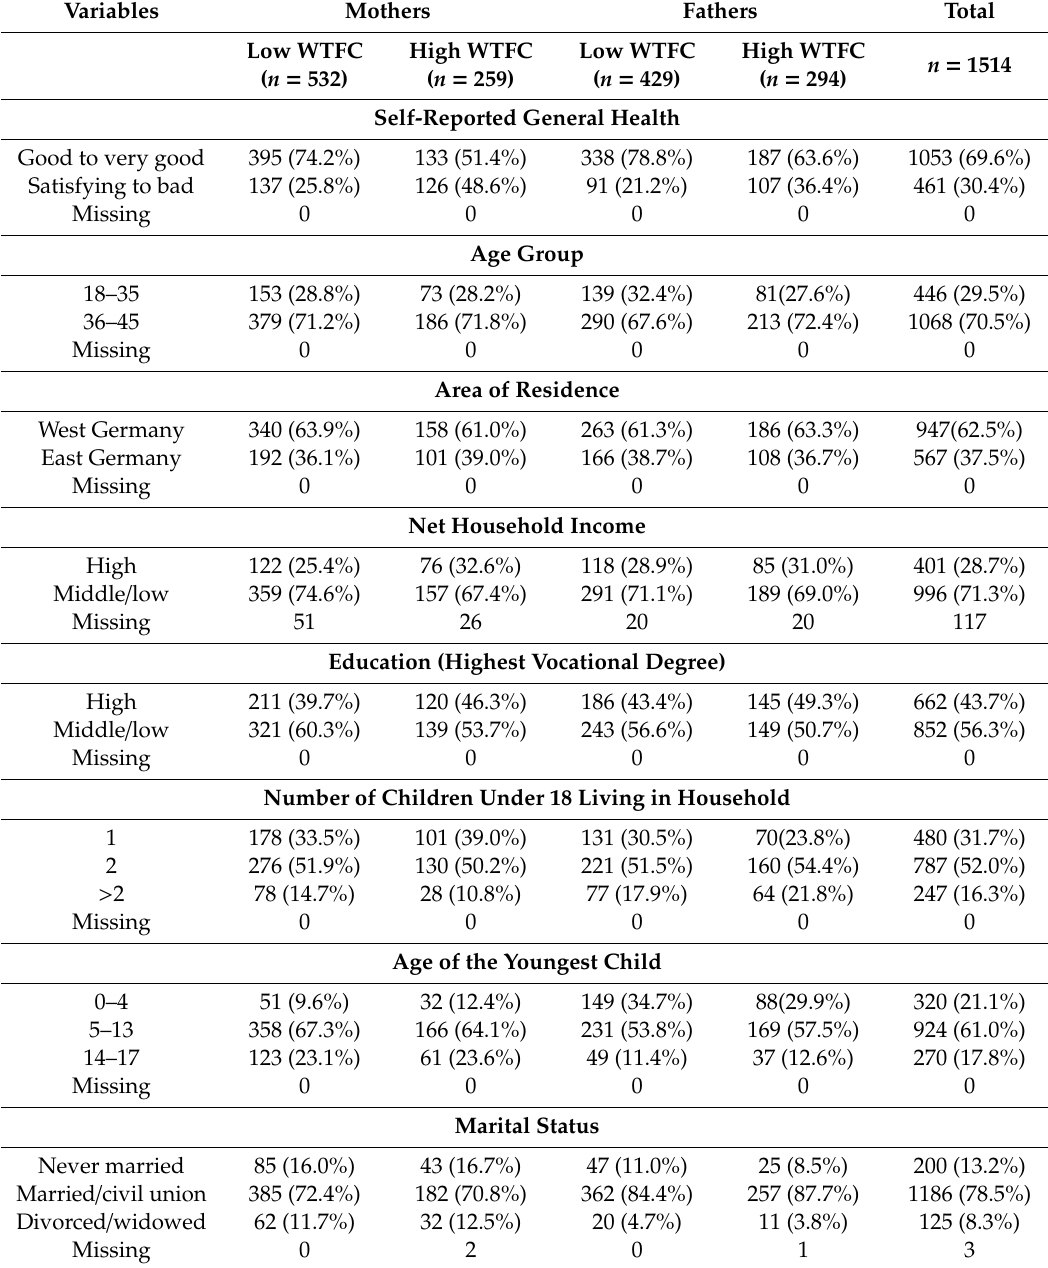
Table 1. Sample description by low and high work-to-family conflict (WTFC), unweighted frequencies, and percentages at